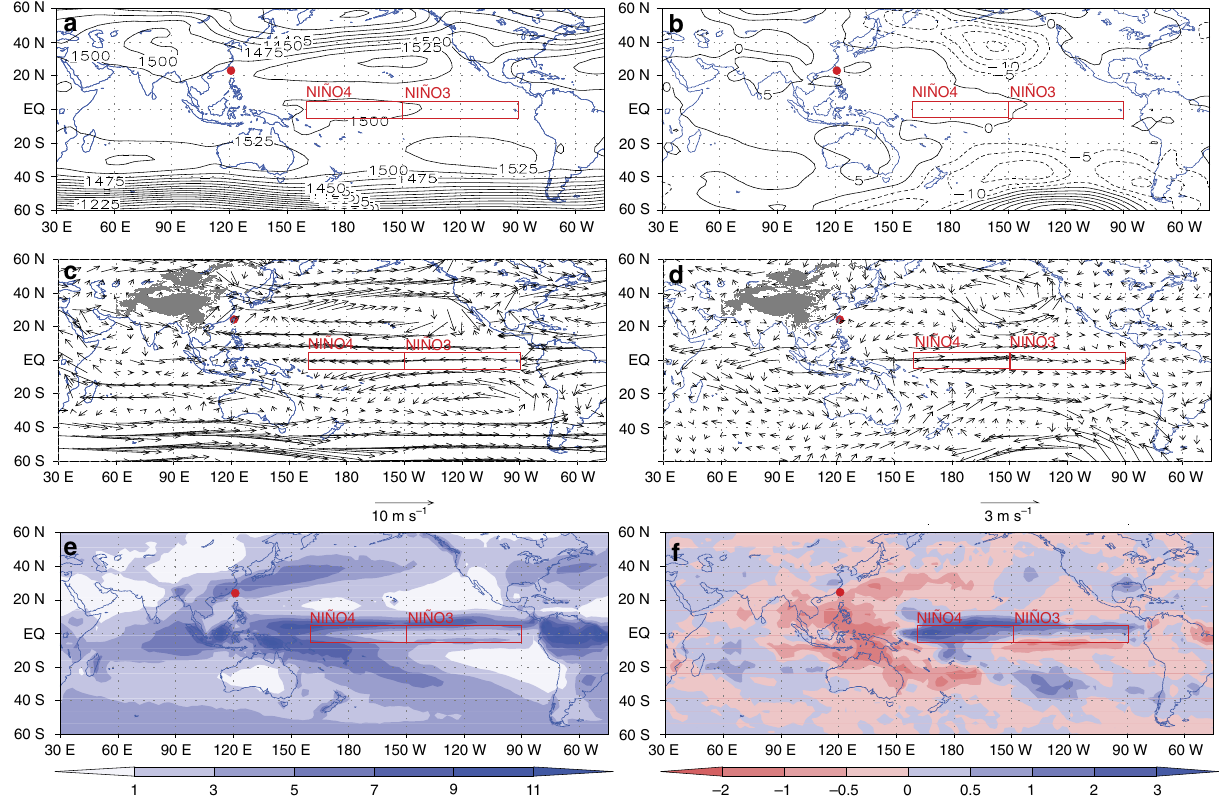
Figure 5 | Climate variability in Taiwan related to central Pacific sea-surface temperature. Long-term (1981–2010) mean geopotential height filed ( a , unit: geopotential metres, gpm) and wind field ( c , unit: ms (cid:2) 1 ) at the 850hPa pressure level retrieved by the National Centers for Environmental Prediction/the National Center for Atmospheric Research reanalysis data 32 , and precipitation field ( e , unit: mm per day) retrieved by global precipitation climatology project data 55 in the reconstruction season (March–April–May), and the composite anomaly fields of 850hPa geopotential height ( b ), 850hPa wind ( d ) and precipitation ( f ) in eight selected central Pacific El Nino years (1987, 1991, 1992, 1993, 1995, 1997, 2002 and 2005). Red dots are the location of Taiwan. This map was created using the software OpenGrADS Version